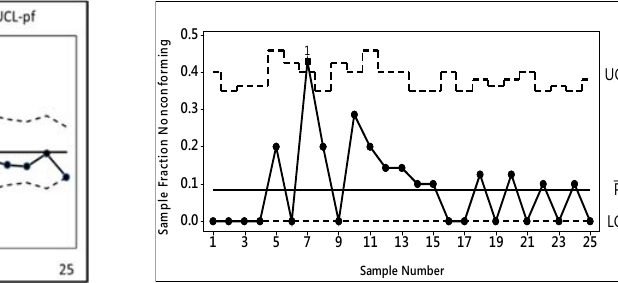
Fig.7. Fuzzy p chart Fig. 8. P control chart for nonconforming